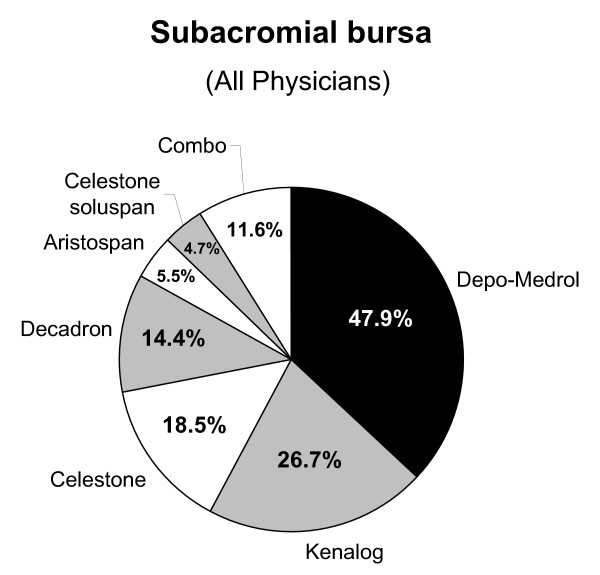
Corticosteroid types used by responding physicians to inject the S-A bursa. Data are shown as the percent of physicians using each corticosteroid type. Note that several physicians use one or two corticosteroids (but not in combination) for a given injection site (see text for details). This accounts for the cumulative percentage of >100% in these figures. These results are grossly similar for the G-H and A-C joints.